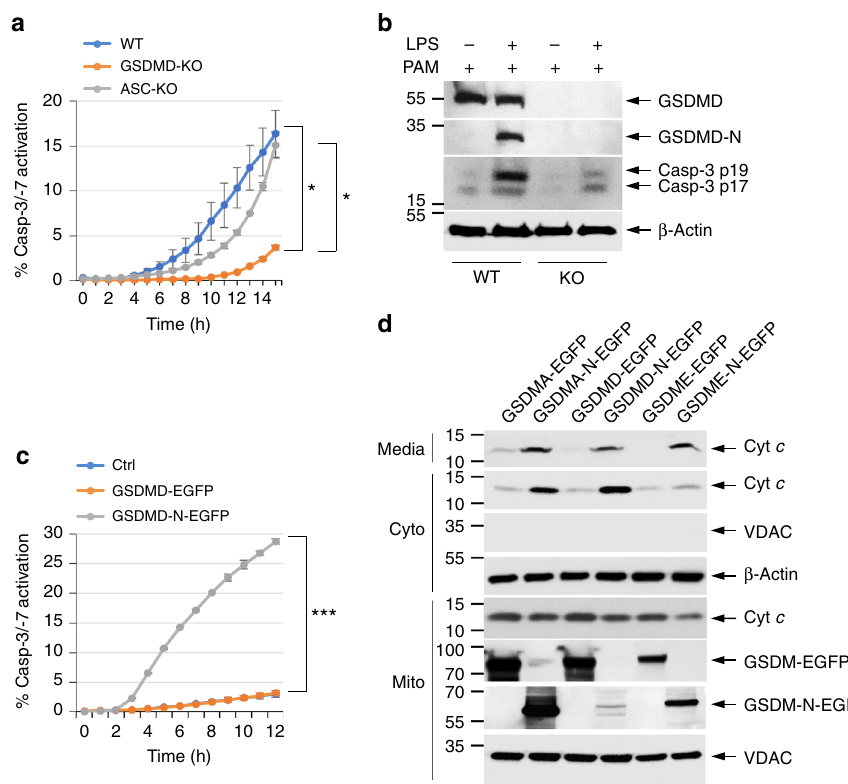
Fig. 8 GSDMD functions downstream of the in fl ammasome to activate caspase-3. a Active caspase-3 staining in PamCSK4-primed wild-type (WT), GSDMD-knockout (KO), or ASC-KO immortalized bone marrow-derived macrophages (iBMDMs) transfected with lipopolysaccharide (LPS; caspase-11 activator) as measured on the IncuCyte over time. b Immunoblots of GSDMD, active caspase-3 p17/p19, and β -actin in cell lysates of PamCSK4-primed WT and GSDMD-KO (KO) iBMDMs untransfected ( − ) or transfected ( + ) with LPS as indicated. c Active caspase-3 in 293T cells transfected with empty vector (Ctrl) or the indicated GSDMD constructs as measured on the IncuCyte over time. d Immunoblots of cytochrome c (Cyt c ; 1st and 2nd panels) released into the culture media (media) or cytosol (Cyto) from 293T cells transfected with the indicated GSDMA, GSDMD, or GSDME constructs. Quantitative analyses of Cyt c release in ( d ) are shown in Supplementary Fig. 19. Results are representative of at least three independent experiments performed in duplicate or triplicate. Error bars represent S.D. Student ’ s t -test, * p < 0.05, *** p <